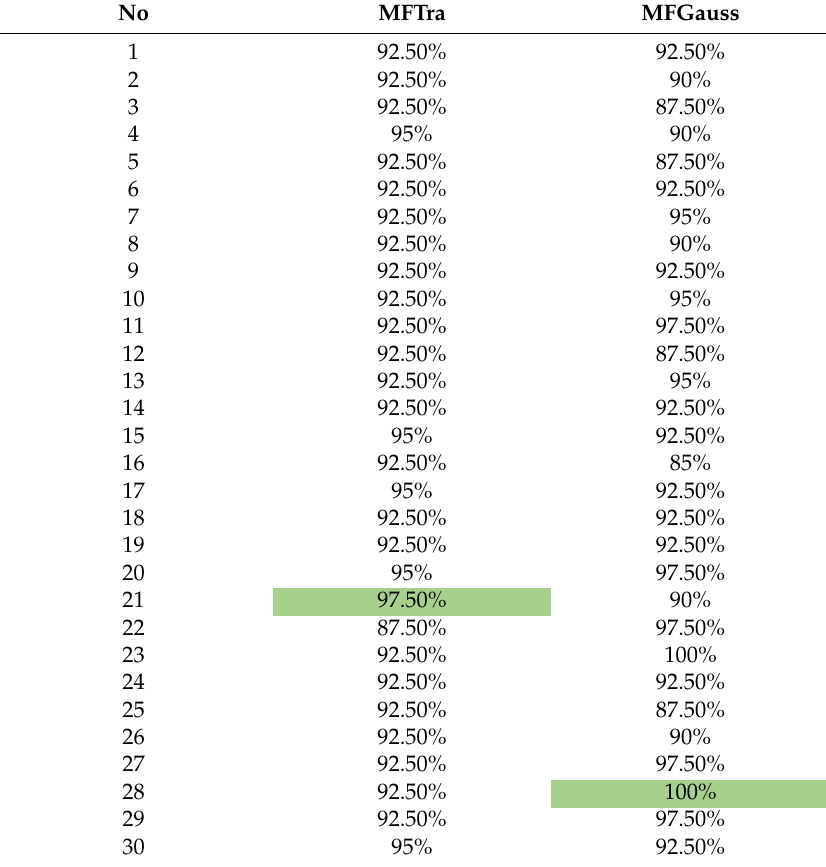
Table 9. Percentage of classification in each experiment with